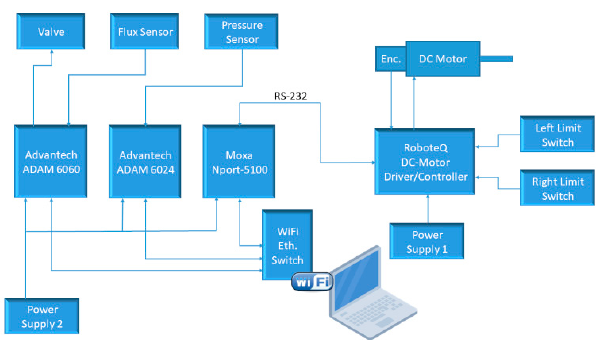
Figure 3. Block diagram of the control system architecture.